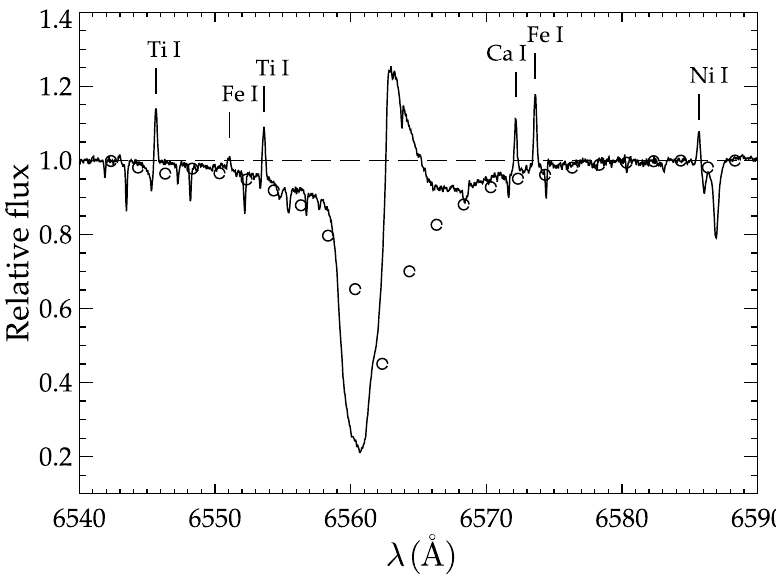
Fig. 1. The H (cid:11) line observed on 2009-09-28. The circles denote the synthetic pro(cid:12)le calculated with the adopted metal-de(cid:12)cient model (6600/0.8). The calculated pro(cid:12)le is shifted according to radial velocity of the star. Some weak emission lines of neutral metals are also